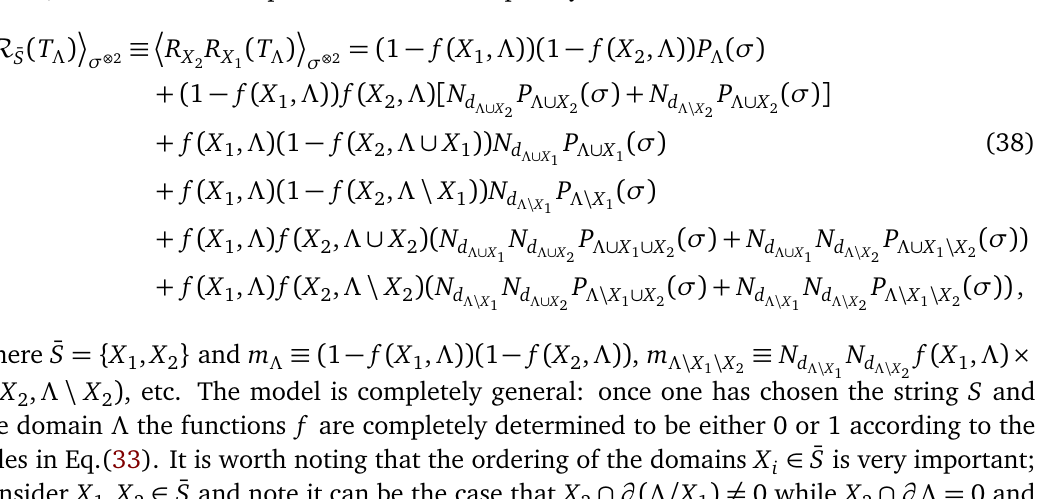
= { X } and thus we , X ( a ) 1 2